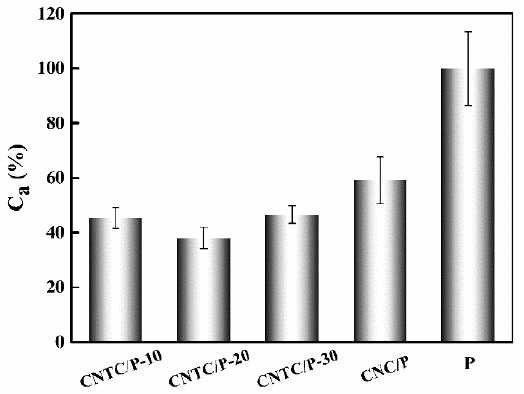
Figure 8. Comprehensive fouling adhesion rate (C a ) of studied coatings.